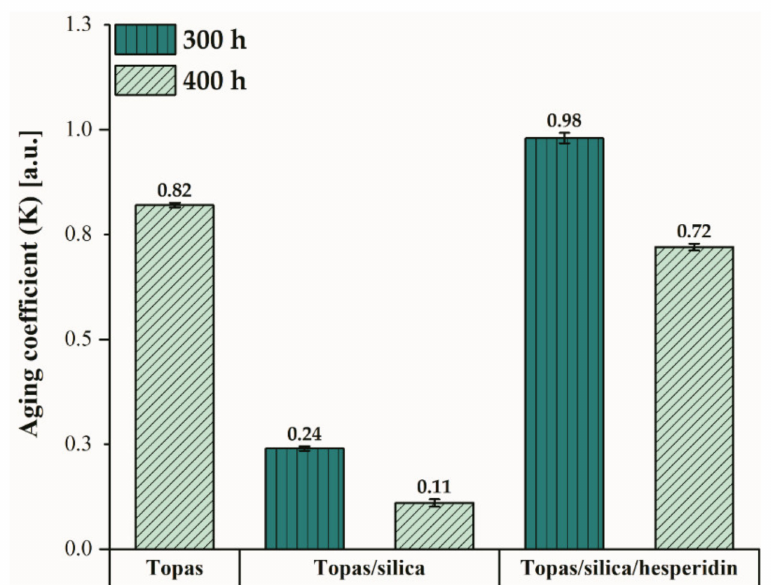
Figure 6. Aging coefficient values for pure Topas after 400 h of weathering and for Topas blends with silica and silica with hesperidin after 300 and 400 h of aging,